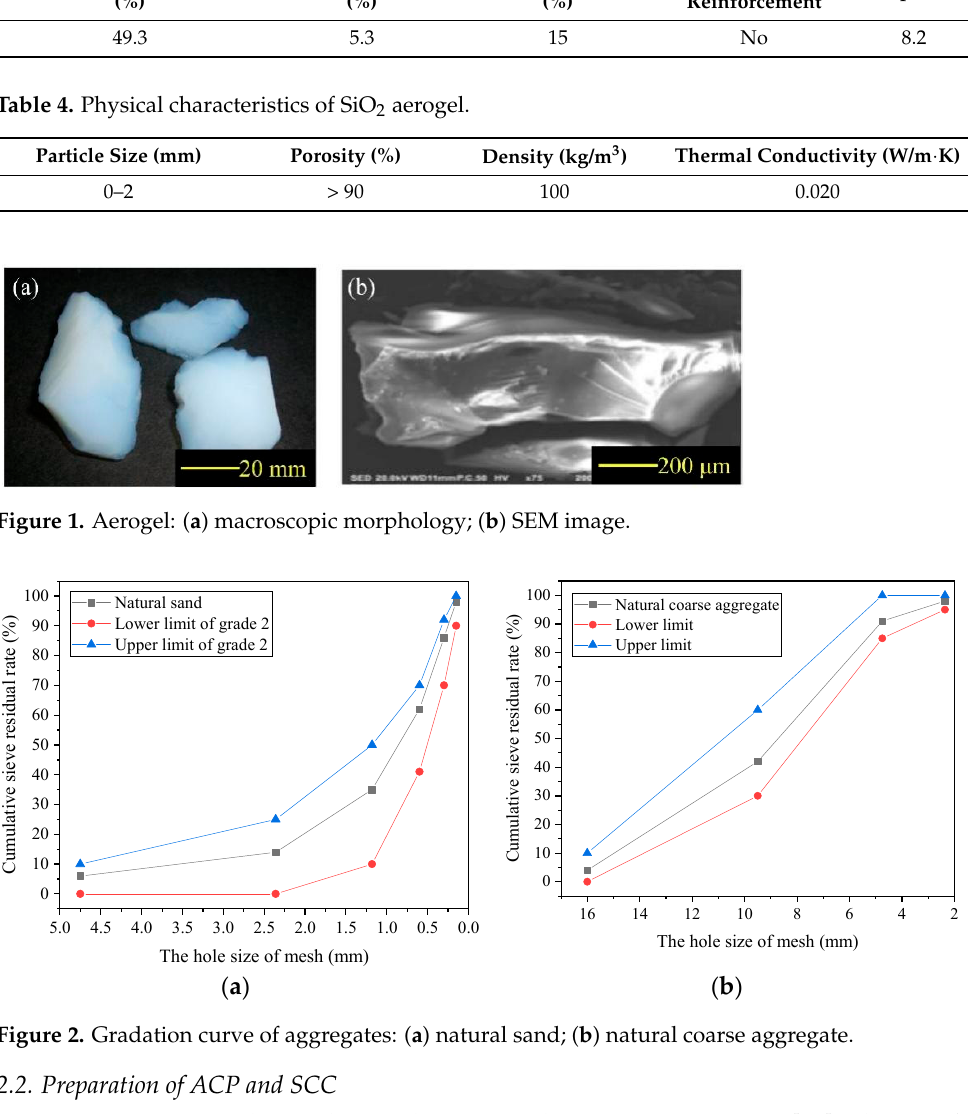
Table 3. Performance parameters of air-entraining agent.